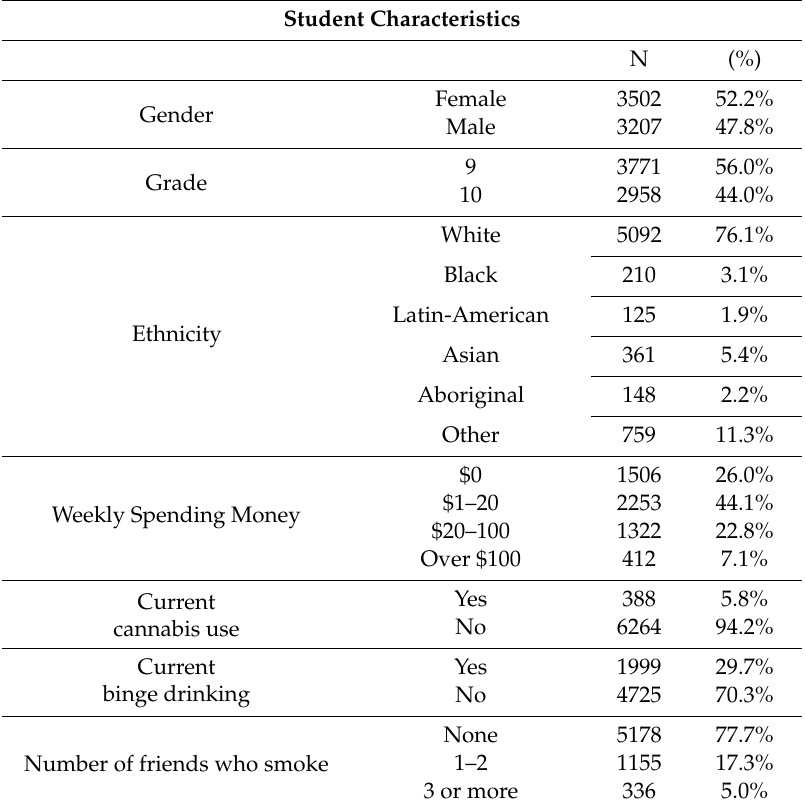
Table 1. Baseline characteristics of the linked longitudinal sample (n = 6729).